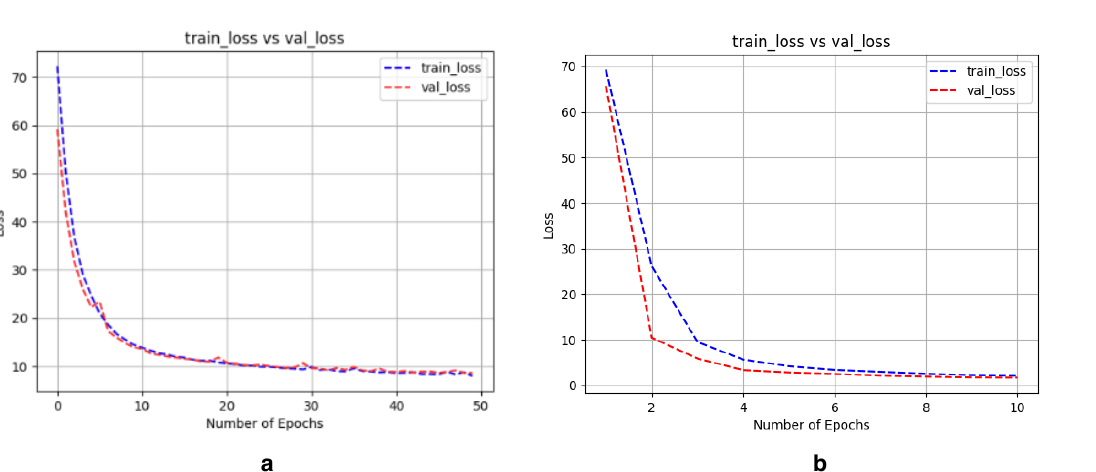
Figure 7. Learning loss comparison: ( a ) The training and validation losses of CTC in the original paper [9] recorded for 50 epochs. ( b ) The training and validation CTC-loss of the proposed model recorded for 10 epochs.